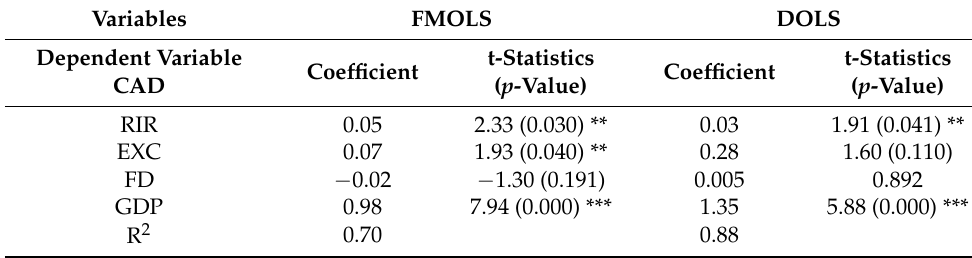
Table 13. Findings of FMOLS and DOLS for LMIE.